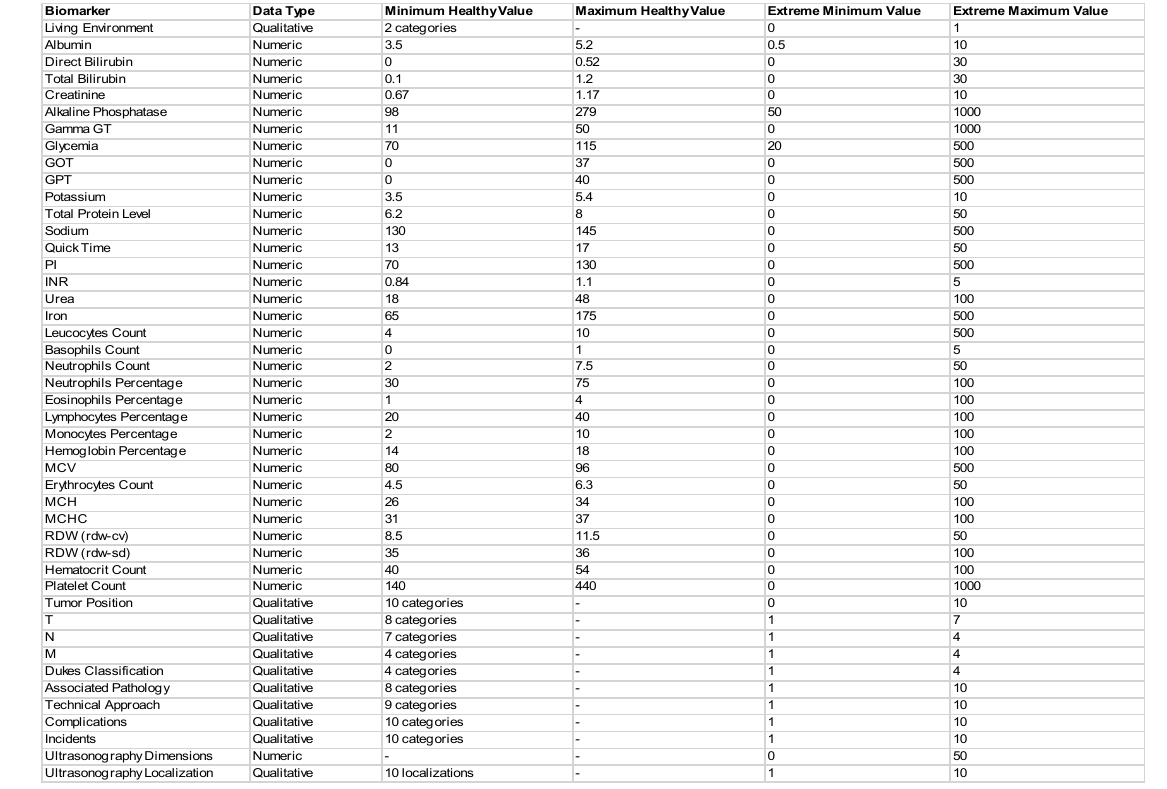
Figure 1. The structure of the novel dataset composing of numeric and qualitative clinical data.